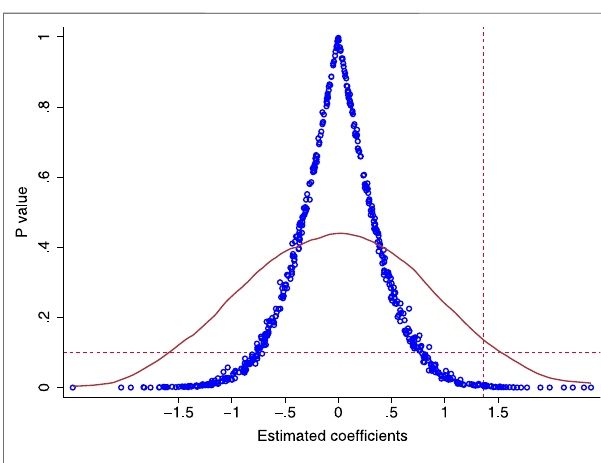
FIGURE 8 | Placebo trend test result of clean power